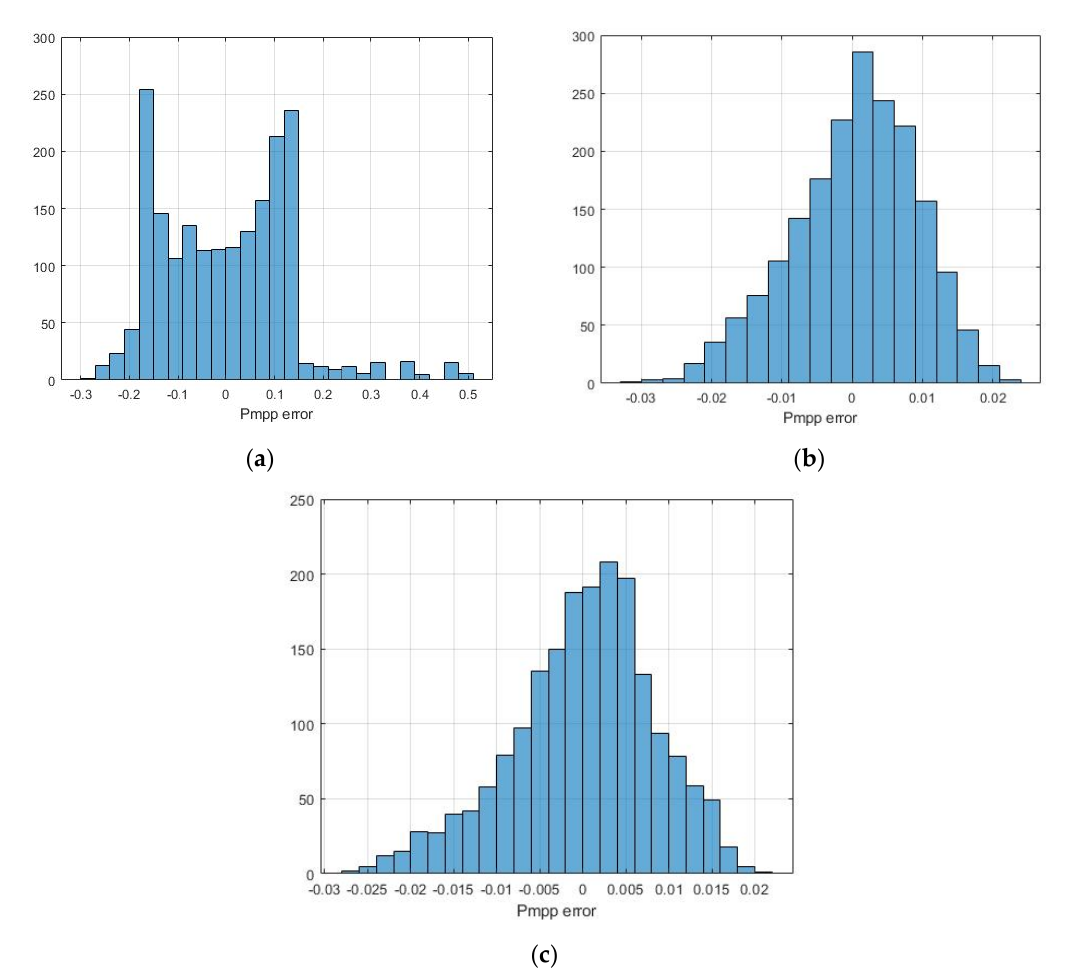
Figure A2. Error frequency distributions with ( a ) curve fit, ( b ) feed forward NN, and ( c ) cascade-forward NN. Error frequency distributions for NN_V are given